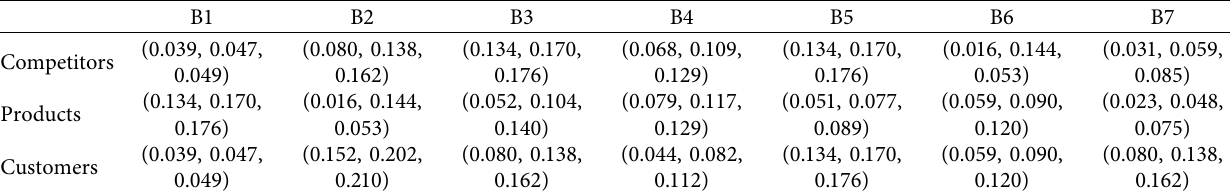
Table 12: Weighted normalized fuzzy decision matrix 􏽥 V .